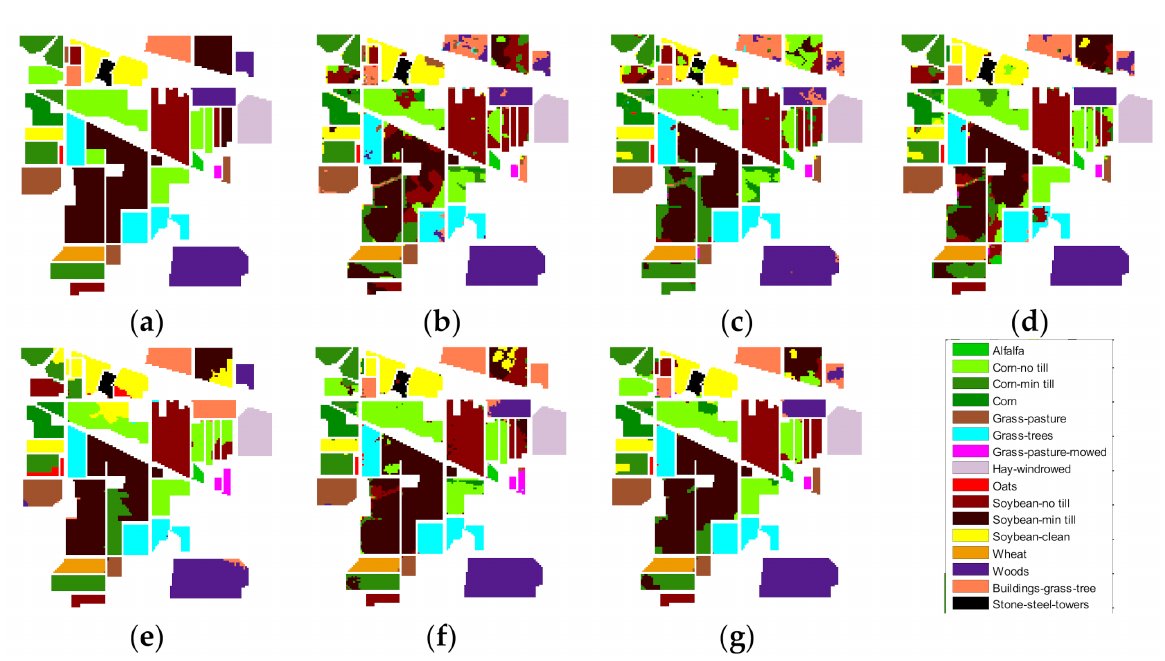
Figure 12. Classification results of different algorithms for the Indian Pines data: ( a ) label, ( b ) joint sparse model and discontinuity preserving relaxation (JSPR). ( c ) RVCANET, ( d ), hyperspectral images based on random multi-graphs (HC- RMG), ( e ), spectral–spatial hyperspectral classification via structural-kernel collaborative representation (SKCR) ( f ) HS_AGU, and ( g )